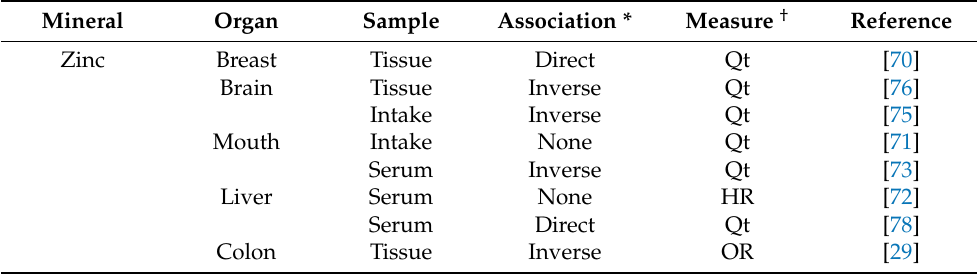
Table 2. Summary of the association between minerals and risk of cancer in observational studies.